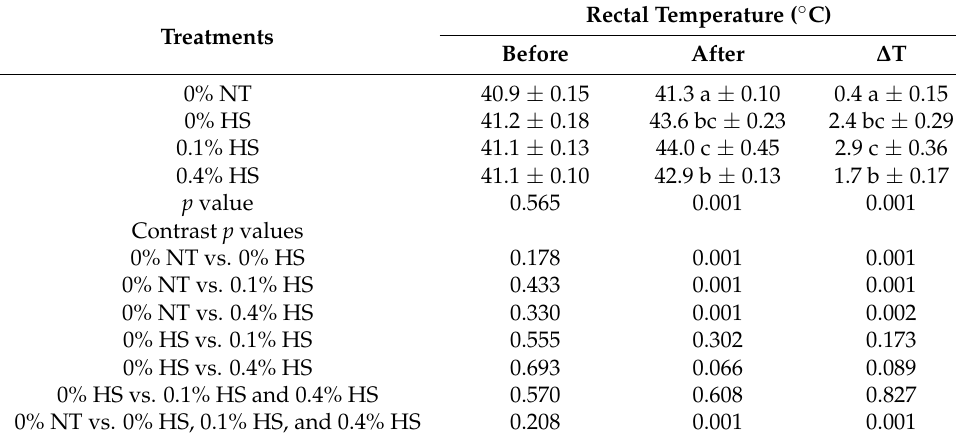
Table 2. Effects of supplementing diets with solubles from shredded, steam-exploded pine particles (SSPPs) on the rectal temperature in broiler chickens exposed to either thermoneutral or heat-stress conditions.